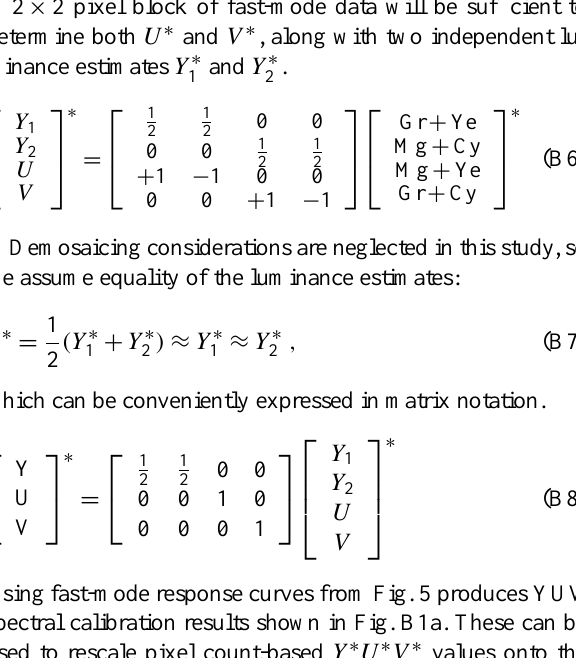
YUV to RGB, so we use definitions from BT601§2.5 (Inter- national Telecommunication Union,